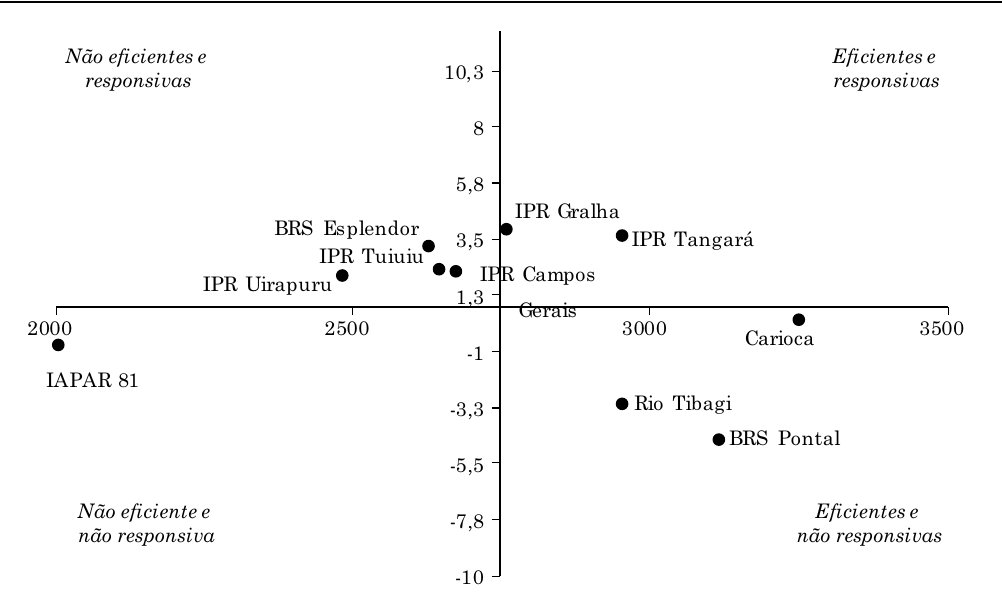
Figura 4. Classificação de cultivares de feijão cultivados na safra da seca-2012 e das águas-2012/2013 em Ponta Grossa, PR, segundo a eficiência no uso do N e na resposta à adubação